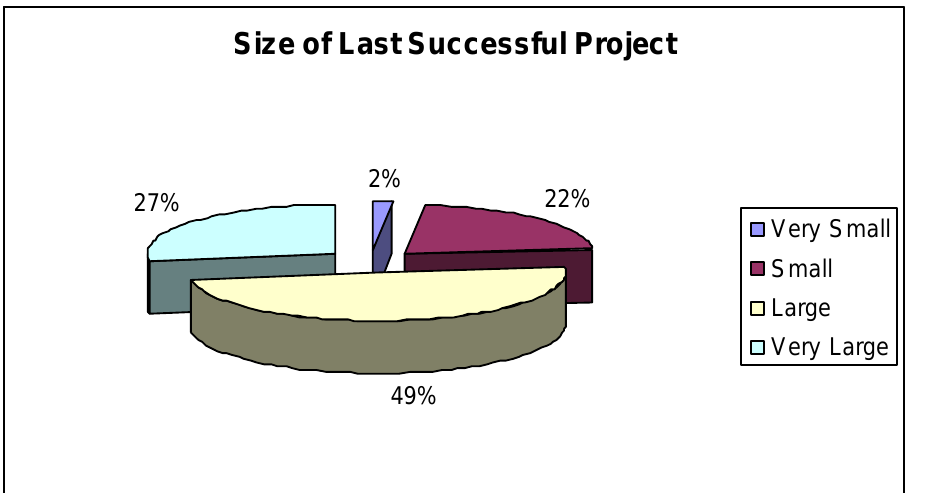
Figure 4: Size of last successful project